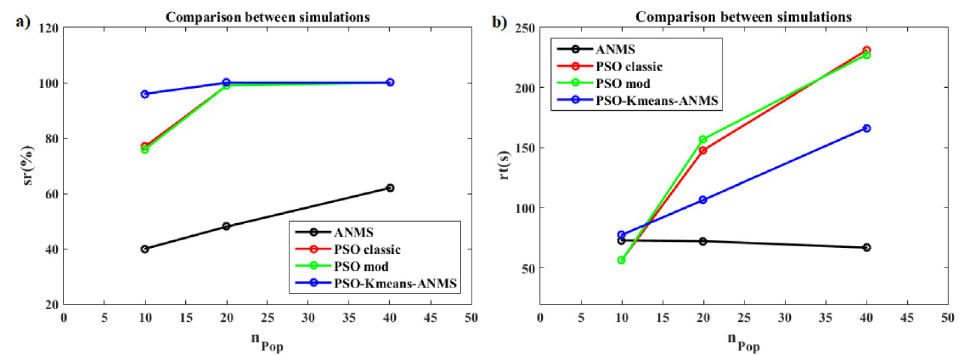
Fig 27. Comparison between simulations for all algorithms and for all cases (1, 2 and 3). (a) success rate, sr (%) versus population and (b) average execution time, rt (s) versus population for the ANMS, PSO classic, PSO mod and PSO-Kmeans-ANMS algorithms.